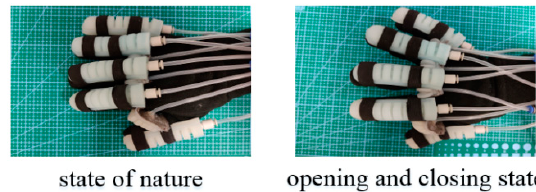
Figure 23. Abduction and adduction of SRGs.